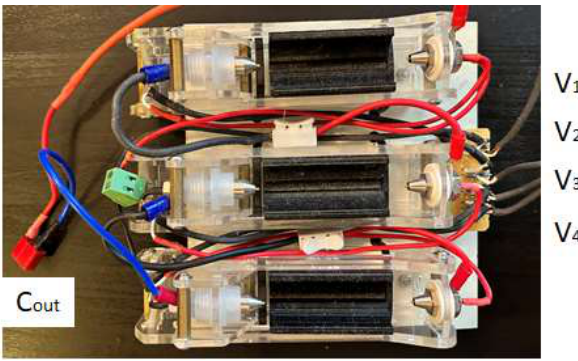
Figure 5. A photo of a device for series connection of three cells.